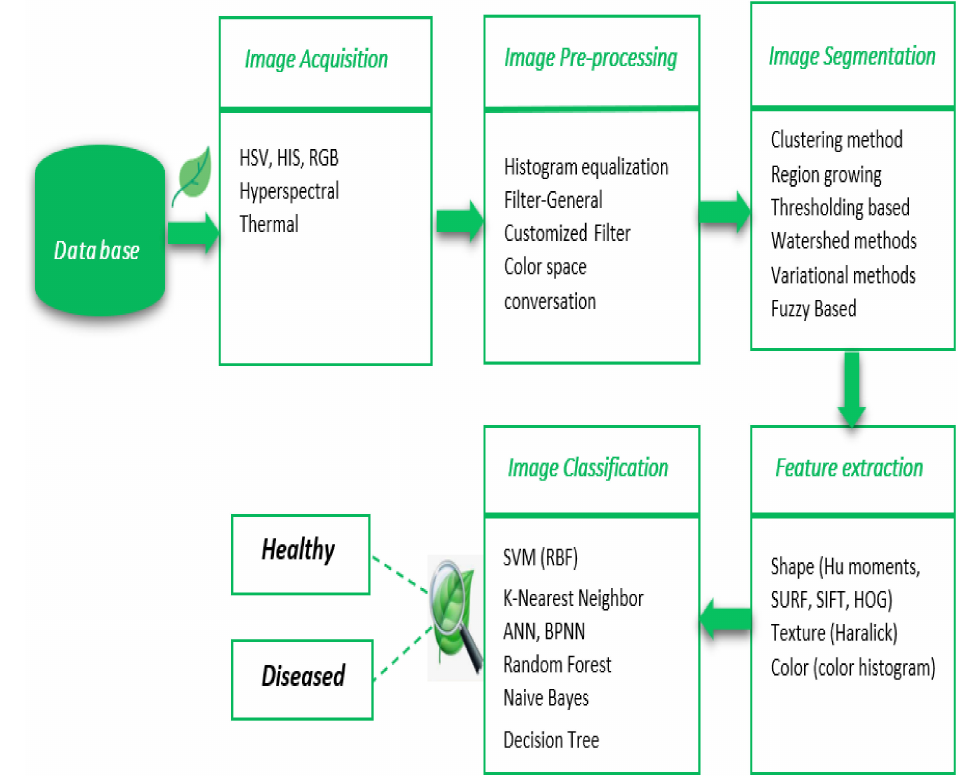
Figure 2. Different approaches for the identification of leaf